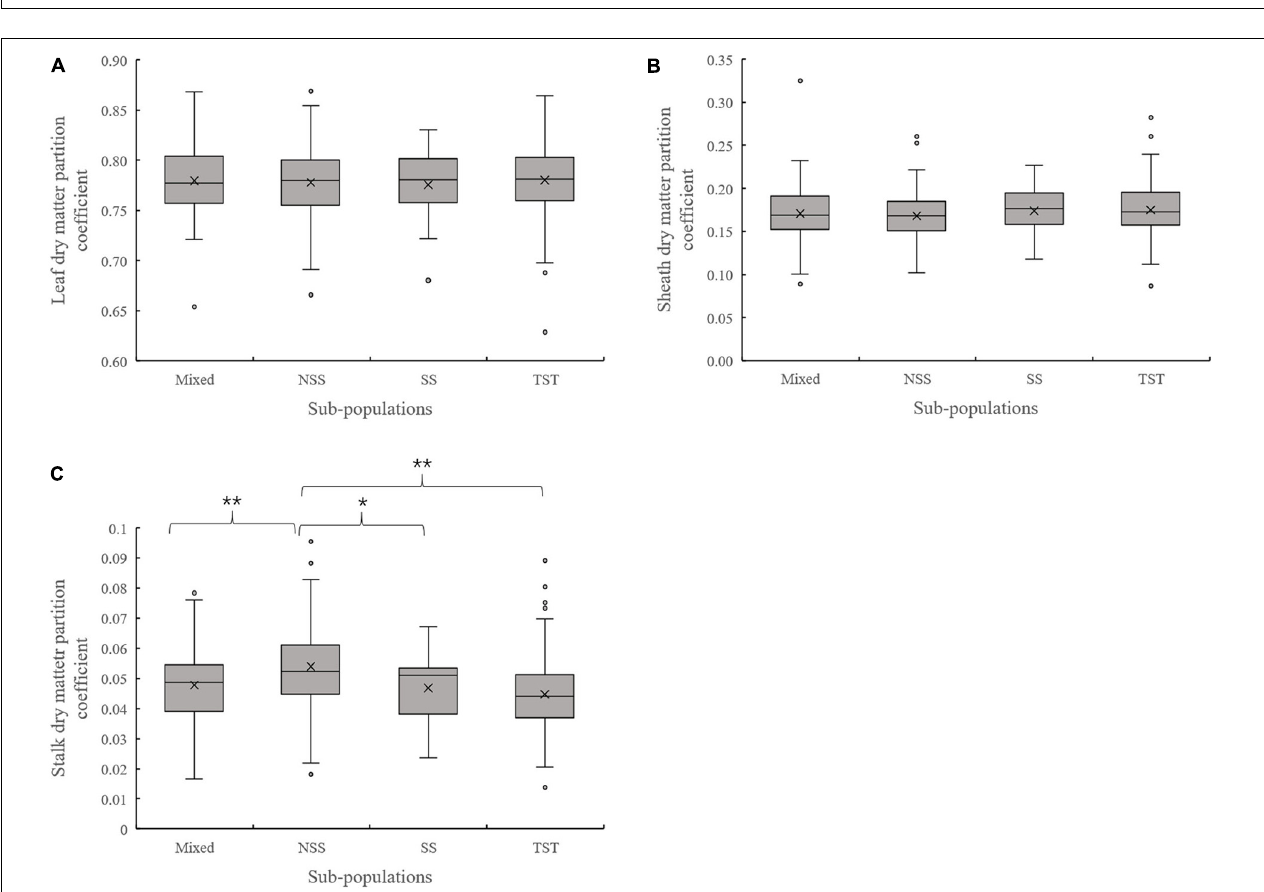
FIGURE 3 | Boxplot of the different organ’s dry matter partition coefficients in different subpopulations at the V3 stage. * denotes significant differences between subpopulations at P ≤ 0.05. (A) Leaf dry matter partition coefficient. (B) Sheath dry matter partition coefficient.